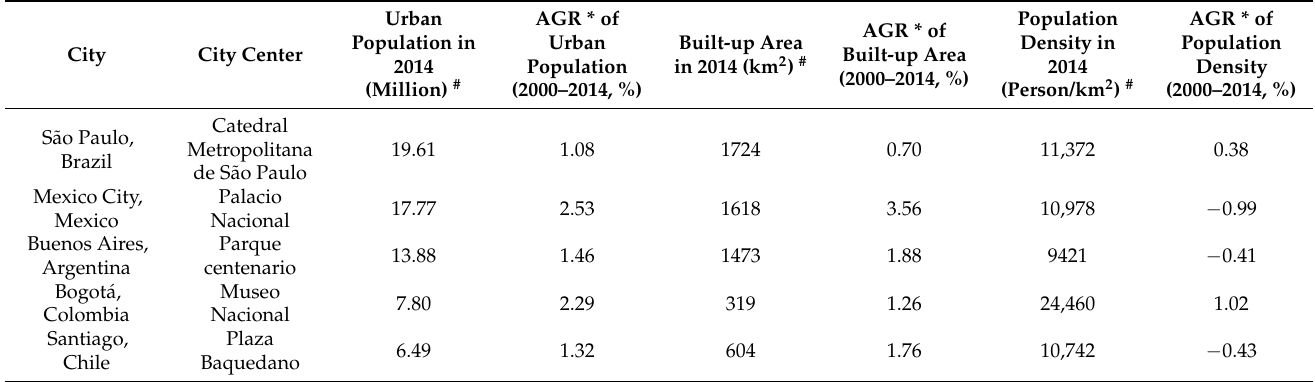
Figure 1. Spatial distributions of five major cities in Latin America with their urban land use in 2000 and 2014. Table 1. Urban population, built-up area, and population density in 2014 and their annual growth rates from 2000 to 2014 in five large Latin American